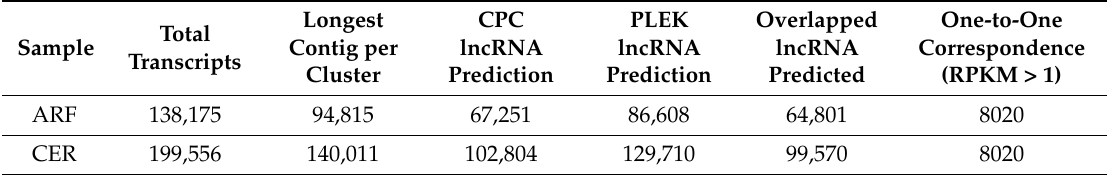
Table 1. De novo transcript assembly and lncRNA identification pipeline results of copaíba from Atlantic Rain Forest (ARF) and Cerrado (CER).